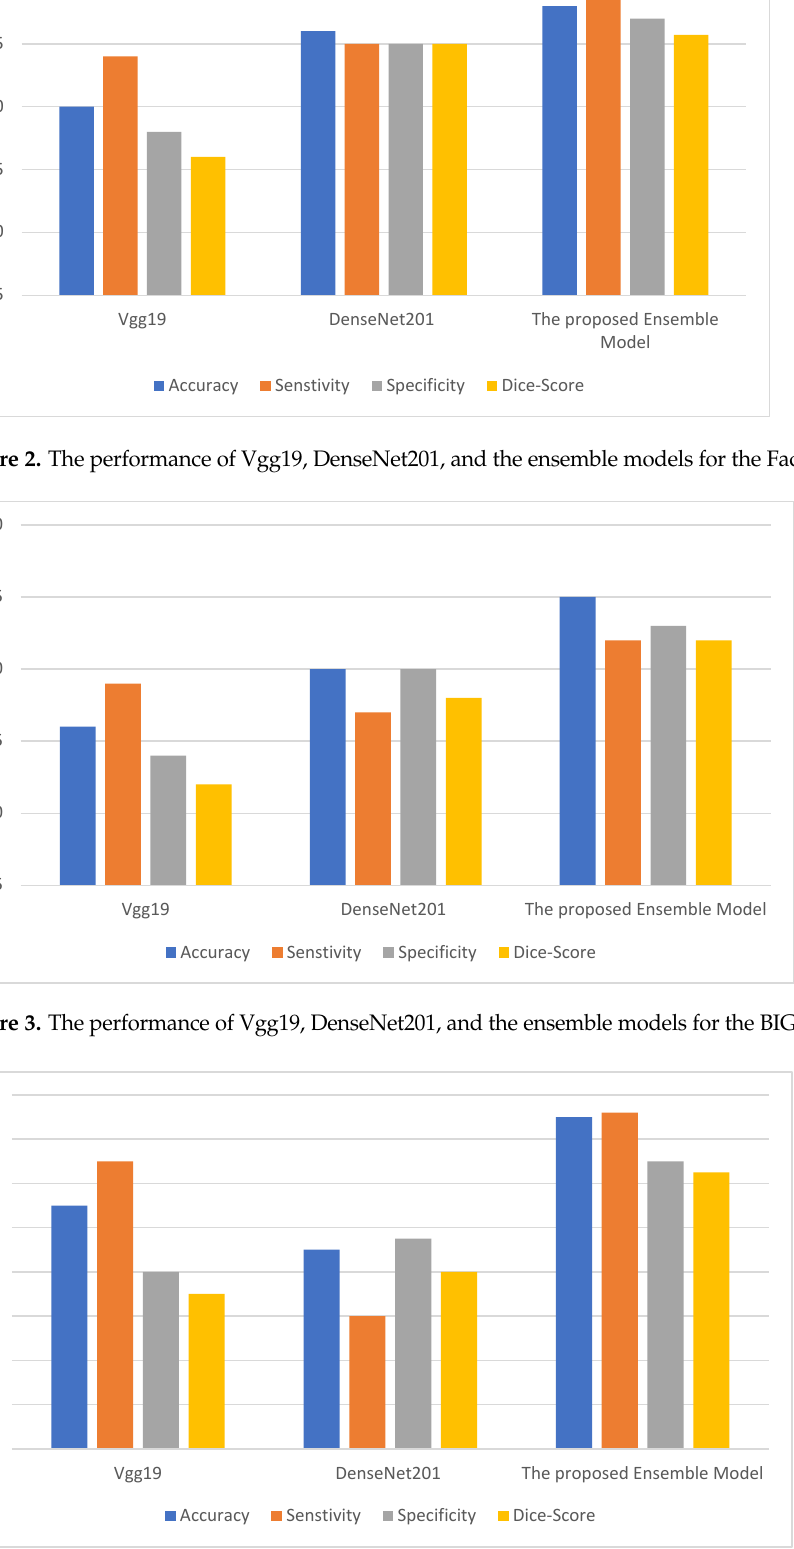
Figure 4. The performance of Vgg19, DenseNet201, and the ensemble models for the TwitD data- base.